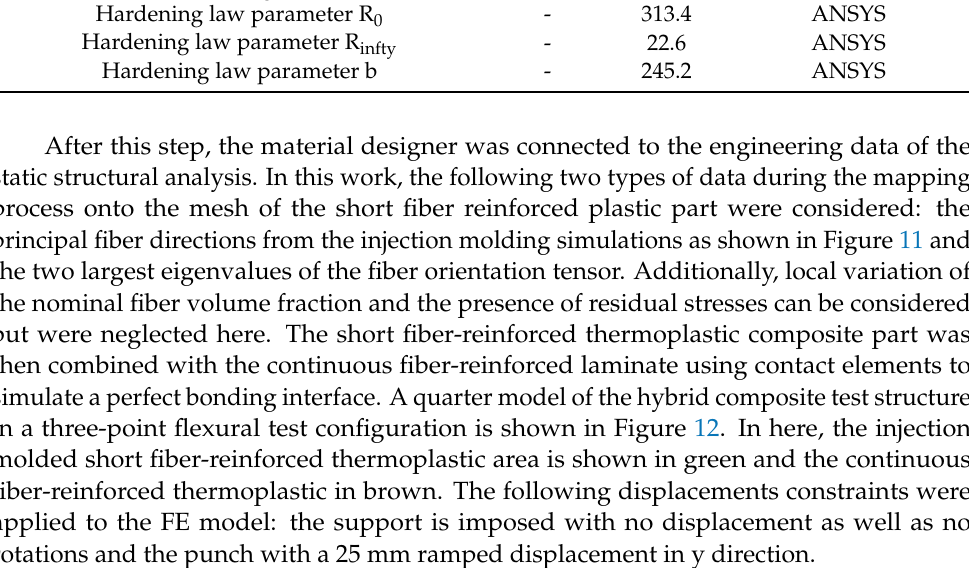
Figure 12. Quarter model of the three-point flexural test of the hybrid injection molded thermo- plastic composite test structure. The injection molded PP/GF30 short fiber-reinforced thermoplastic composite is shown in green and the PP/GF60 continuous fiber-reinforced thermoplastic composite in brown: ( a ) top view and ( b ) bottom view. 3. Results and Discussion 3.1. Anisotropy of Injection Molded Short Fiber-Reinforced Thermoplastic Composites The results of the tensile tests of the PP/GF30 short fiber-reinforced thermoplastic composite material are shown in Figure 13. Anisotropic and inhomogeneous behavior of the material was found, depending on the volume flow rate and direction during the in- jection molding process of the test plates. This can be seen in the stress-strain-curves of the test specimen cut out in the different directions ( Figure 13a). The highest stiffness and strength were measured in flow direction, while these properties are decreasing with vol- ume flow rate, which can be seen in Figure 13b and Figure 13c. It is also shown that the opposite trend was found perpendicular to the flow direction, while no significant influ- ence of the flow rate on the stiffness and strength in 45° to the flow direction was found. However, in this direction the highest strain at break was measured, without any signifi- cant influence of the flow rate, as shown in Figure 13d. These trends correlate to the flow rate dependent short fiber orientation mechanisms during injection molding as published by Bay and Tucker III [35,36]. As reported by Oumer and Mamat [37], at low flow rates the short fibers are more oriented in the flow direction and therefore the stiffness and strength of the composite are higher in this direction. Given the results shown in Figure 13, the same mechanism has to be stated for the PP/GF30 short fiber-reinforced composite material used in this study. To validate this effect, CT measurements of the fiber orientation in the processed PP/GF30 short fiber-reinforced thermoplastic composite test samples have been analyzed.